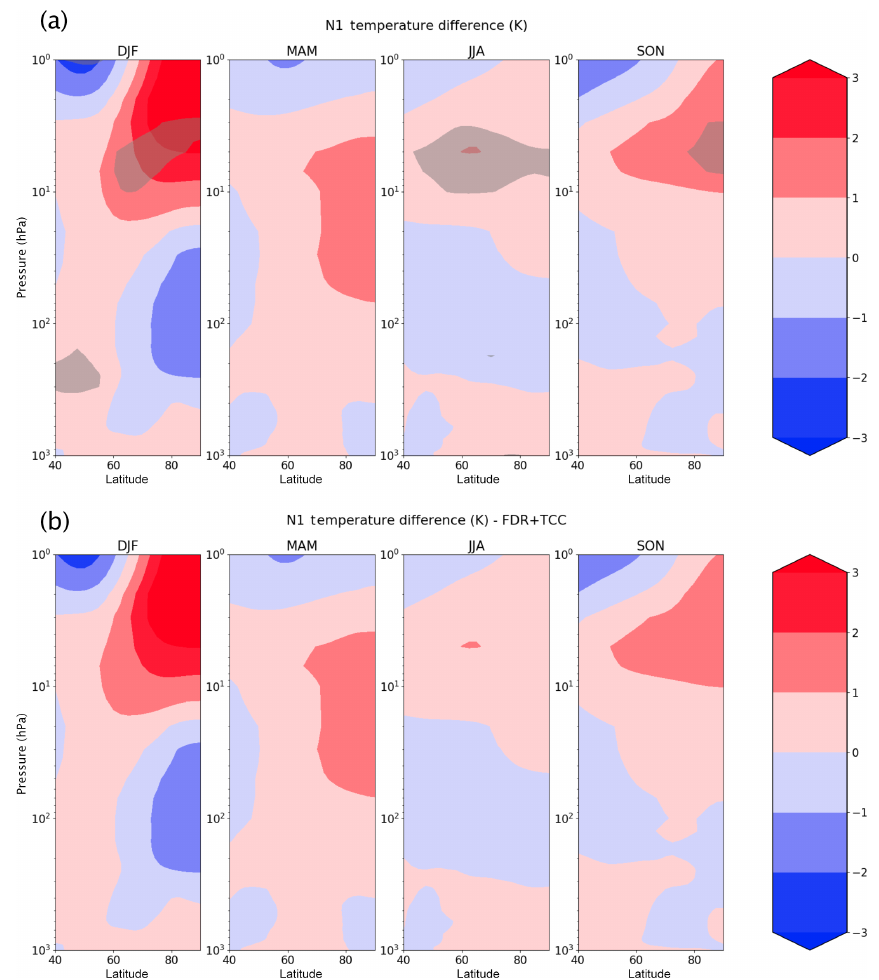
Figure 7. Zonal mean temperature differences (high-Ap–low-Ap values) without (a) and with (b) temporal (TCC) and spatial (FDR) auto- correlation corrections. The grey areas indicate statistically significant temperature differences at the 5% confidence